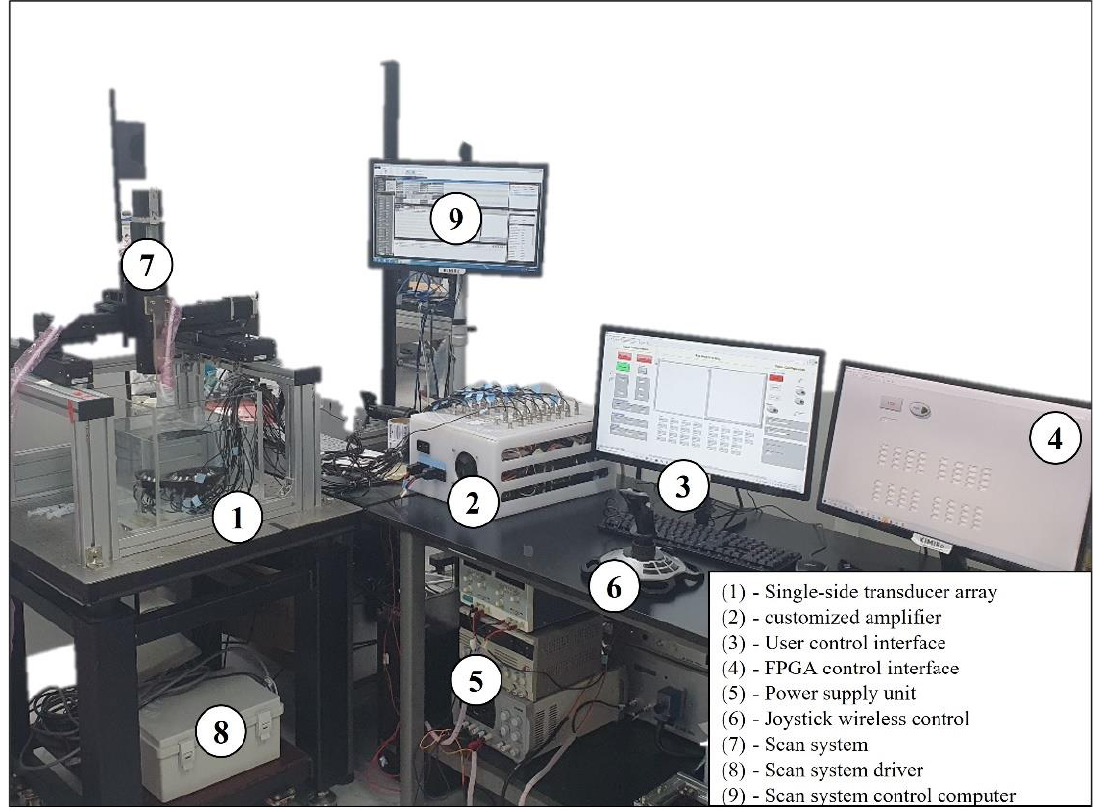
Figure 3. Experimental setup for the acoustically driven Macbots in water.